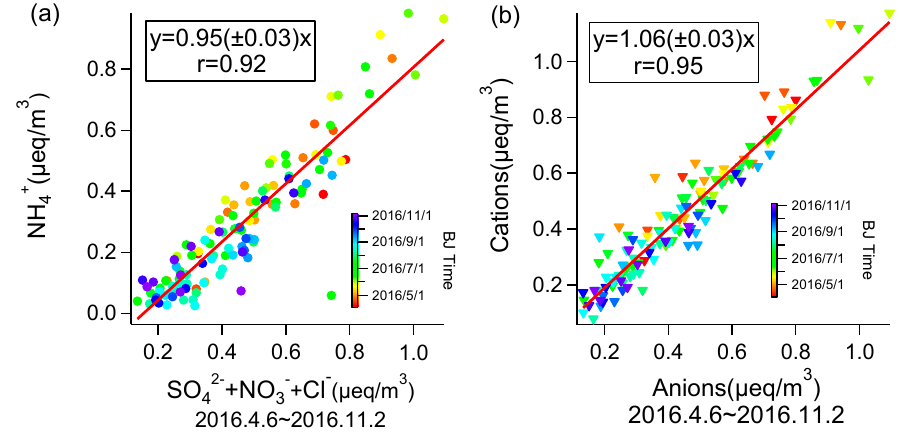
Figure 6. Scatter plots of molar ratios of ammonium versus sum of sulfate, nitrate, and chloride ( a ), and cations versus anions ( b ) (colored by time).